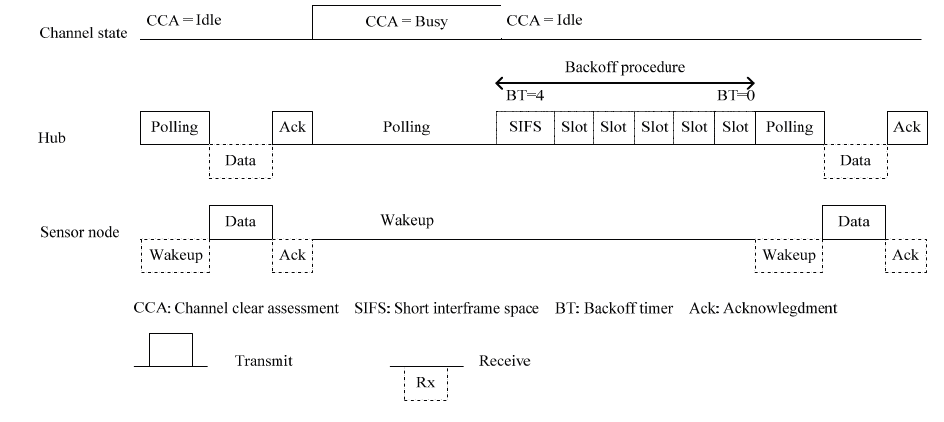
Figure 7. Polling with a backoff mechanism in